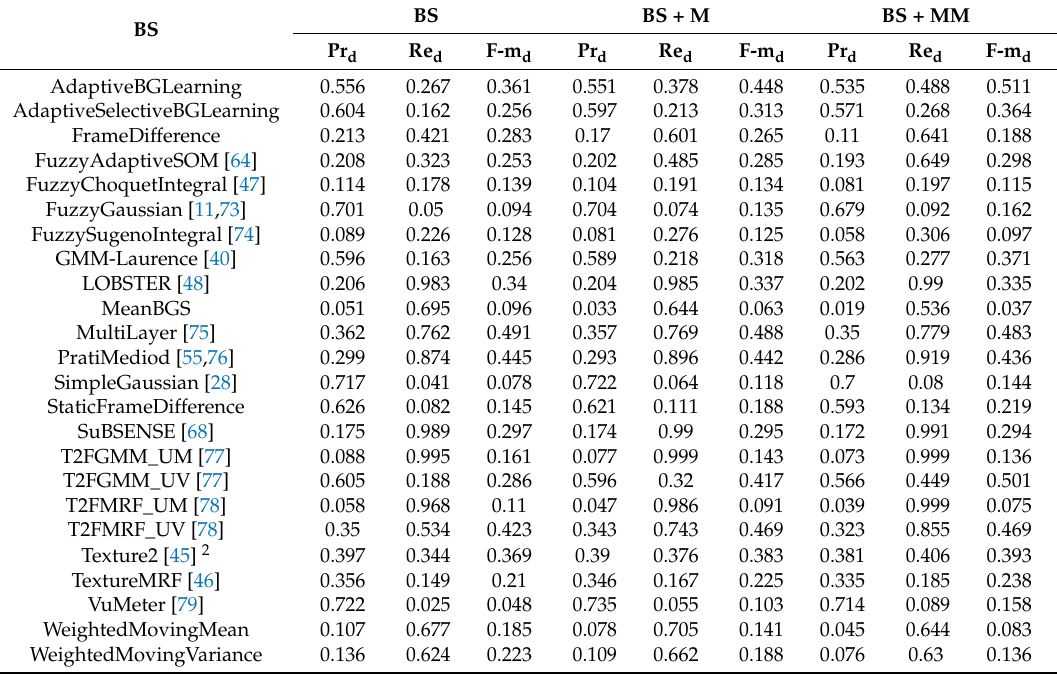
Table 22. The Evaluation Results of the BS, and BS with post-processing with the